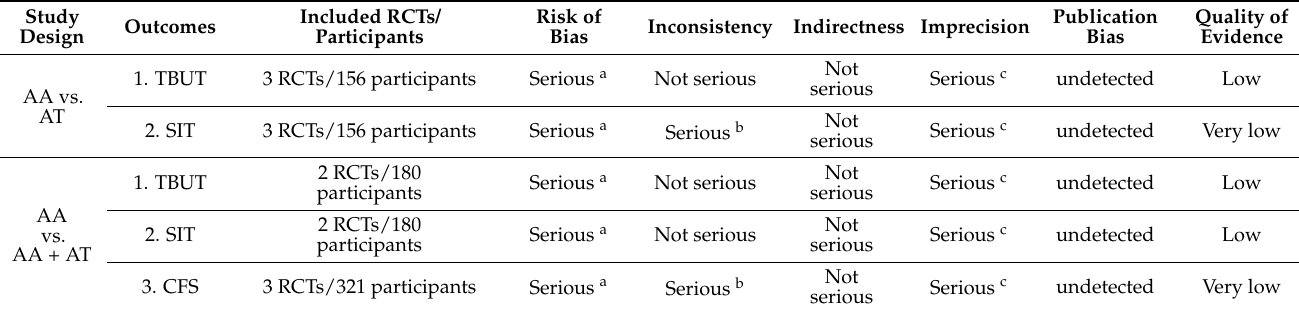
Table 2. Quality of evidence in included systematic reviews with GRADE.